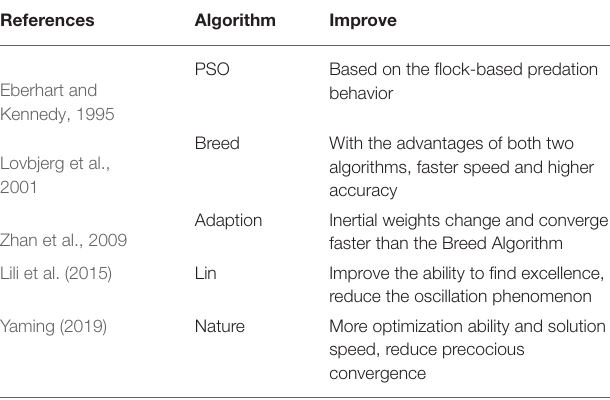
TABLE 2 | Particle swarm optimization and its improved